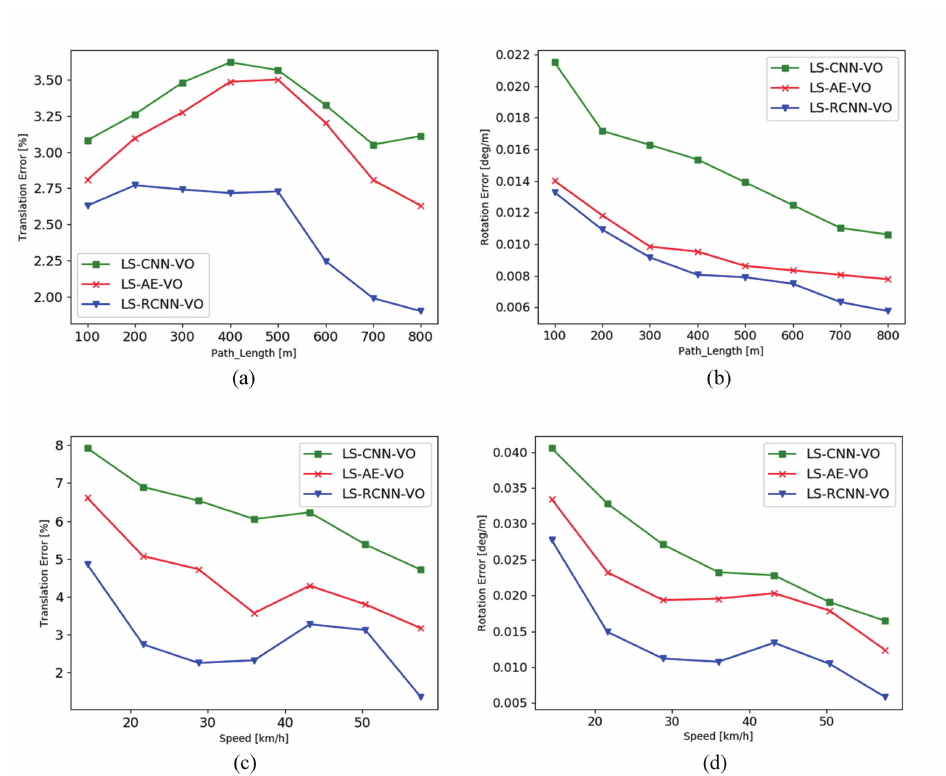
Figure 6. Comparison of the average translation error (ATE) and the average rotational error (ARE) of the three models at different path lengths and speeds on KITTI dataset. ( a ) ATE versus path length, ( b ) ARE versus path length, ( c ) ATE versus speed, and ( d ) ARE versus speed.